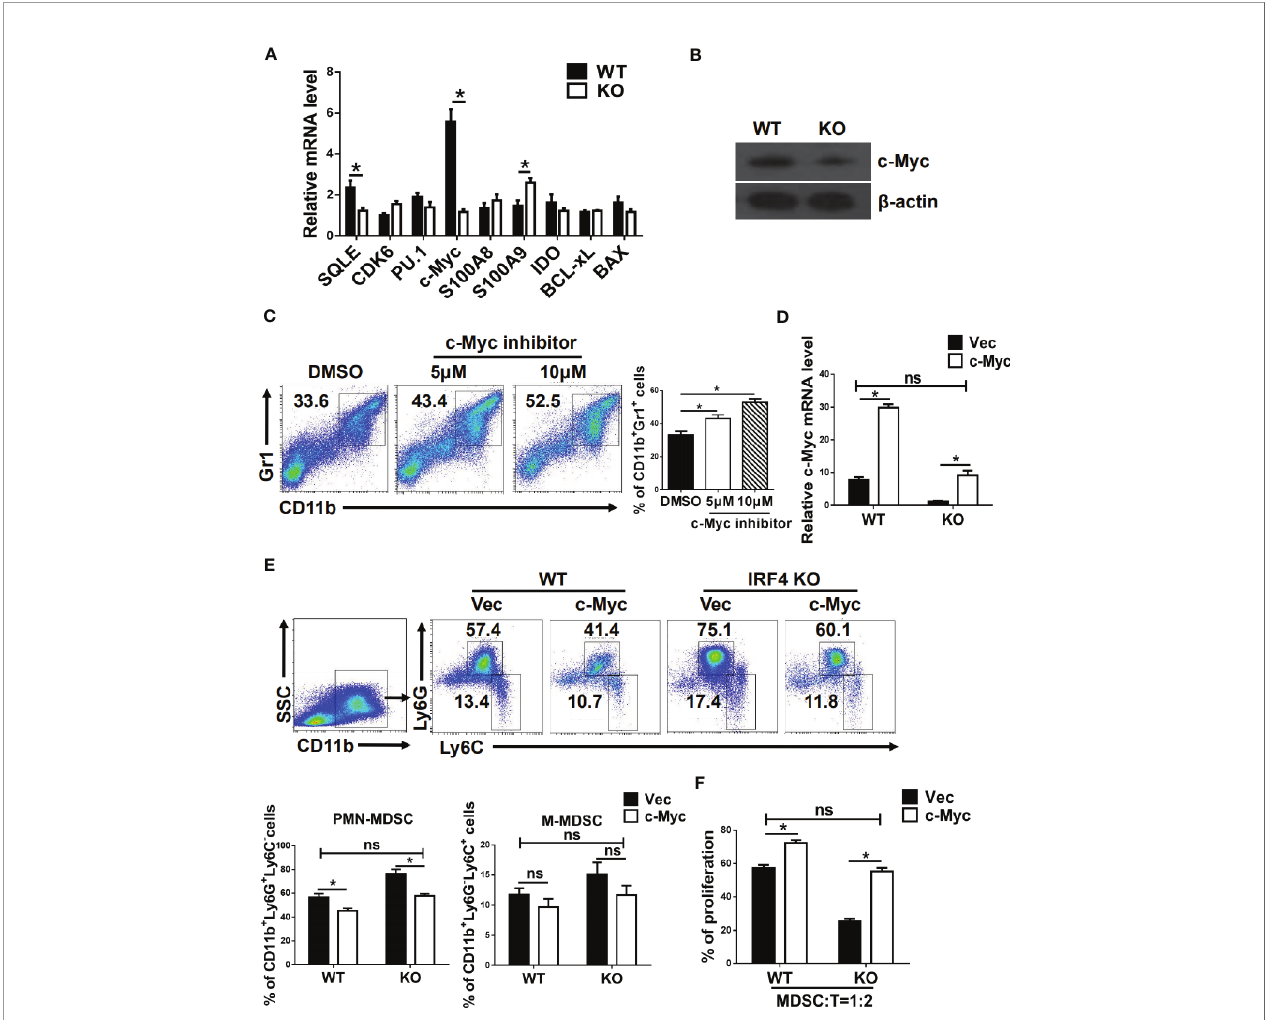
FIGURE 5 | c-Myc mediates the effects of interferon regulatory factor 4 (IRF4) on myeloid-derived suppressor cells (MDSCs) development. (A, B) Gene expression in sorted MDSCs was determined by quantitative RT-PCR (qRT-PCR) (A) and western blot (B) . (C) Mouse bone marrow (BM) cells from normal mice were cultured in medium containing GM-CSF and IL-6 with the different concentrations of c-Myc inhibitor (10074-G5). The proportions of the indicated populations were determined by fl ow cytometry after 5 days of culture. (D – F) BM cells from WT or KO mice were infected with lentivirus expressing c-Myc or an empty vector. (D) The c-Myc gene expression was determined by qRT-PCR after 48 h of culture. (E) The proportions of indicated populations were determined by fl ow cytometry after 5 days of culture. (F) MDSCs were puri fi ed by fl ow cytometric sorting. Allogeneic CD3 + T cells (from BALB/c mice) were stimulated with Con A and then co-cultured with isolated PMN-MDSCs at 2:1 ratios for 3 days. T cell proliferation was evaluated by 5,6 carboxy fl uorescein diacetate succinimidyl ester (CFSE) dilution. A comparison of the suppressive activity on CD3 + T cells between MDSCs from WT or KO mice were infected with lentivirus expressing c-Myc or an empty vector. (A, D, F) Data are shown as the mean ± SEMs from three independent experiments. * P < 0.05, compared with the corresponding controls; unpaired t tests were used. (C, E) Representative results (left) and mean ± SEMs from 3 independent experiments; * P < 0.05, unpaired t